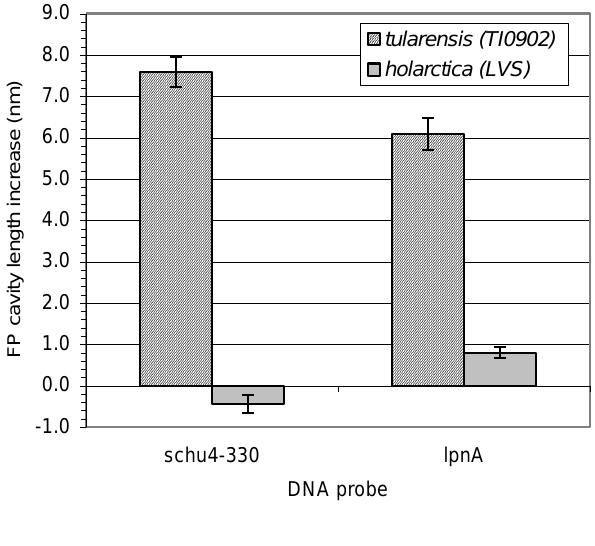
Figure 8. Differentiation of F. tularensis strains TI0902 (type A) and LVS (type B) using FFPI sensors. The probe schu4-330 was unique to type A strain TI0902, whereas, the probe lpnA was common to strains TI0902 and type B strain LVS. The sensors measured a change in optical cavity length that correlated to a given concentration of the